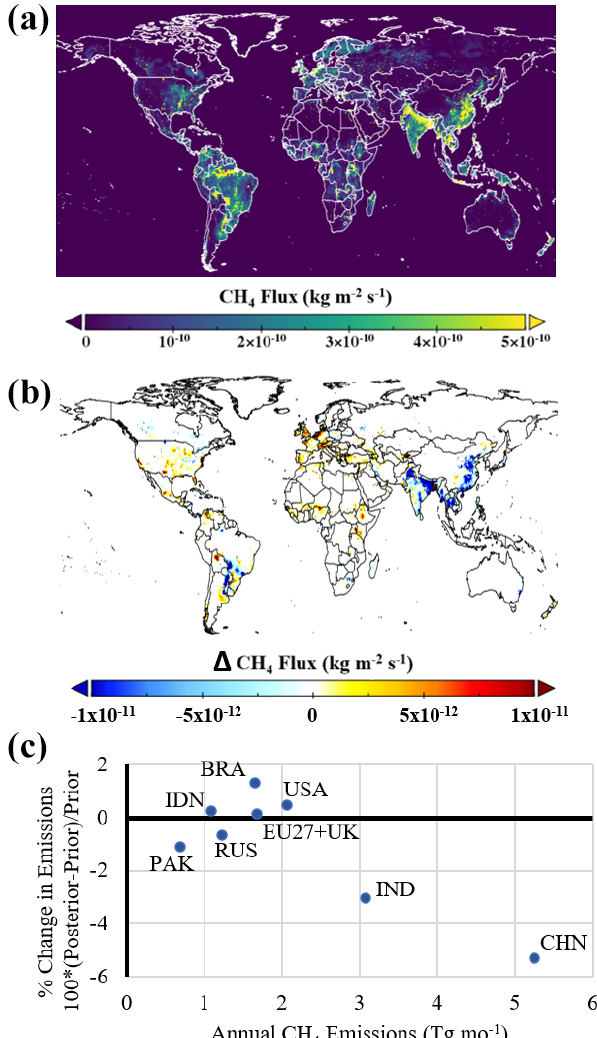
Figure 2. (a) Global annual mean prior CH 4 emissions for 2019 taken from CAMS. (b) Difference between posterior and prior emis- sions averaged between January and June 2019, derived from the IFS inversion. (c) Posterior adjustment, as a percentage of prior, in anthropogenic CH 4 emissions per